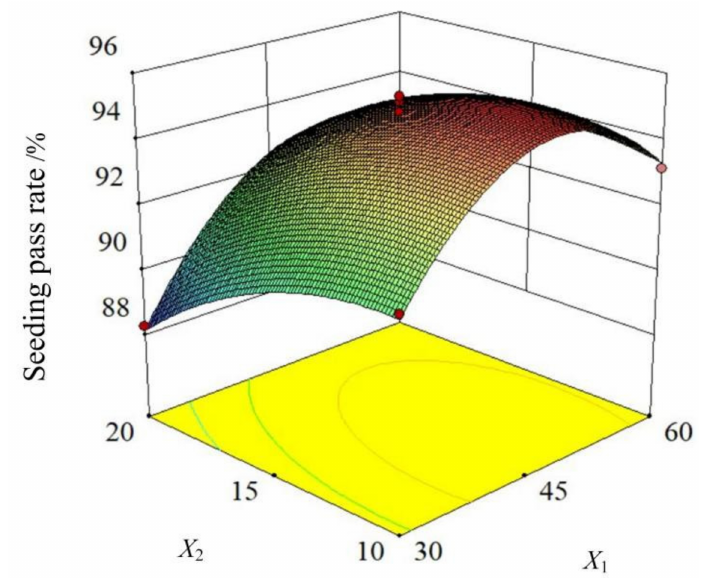
Figure 10. Effect of interaction factors on seeding pass